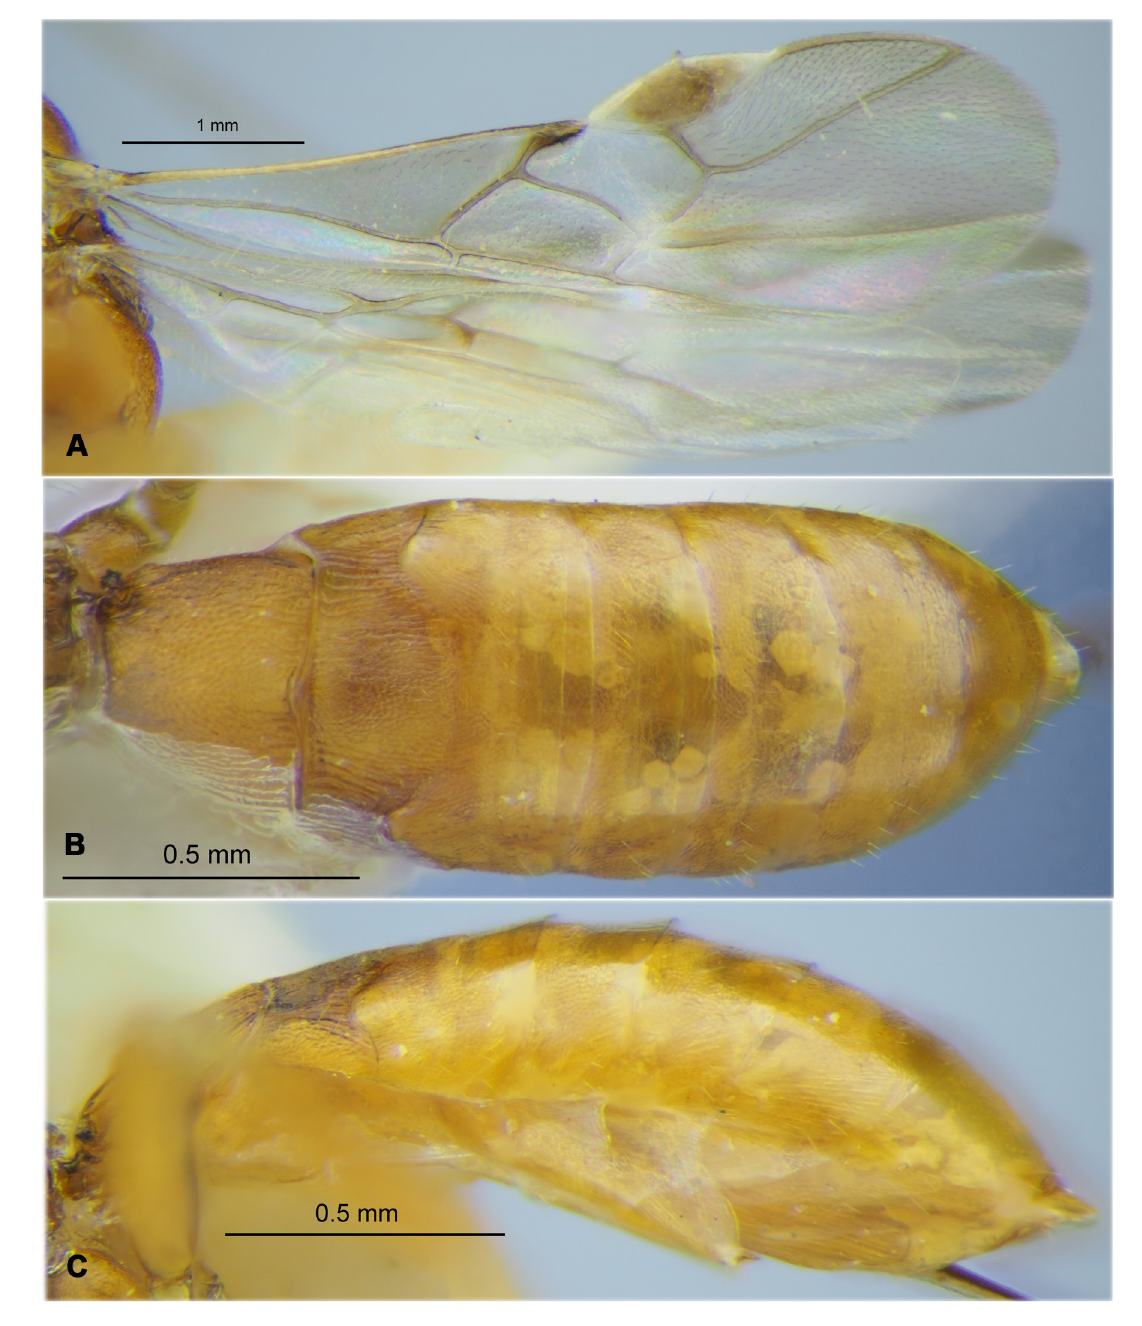
Fig. 33. Hecabalodes xylophagi Fischer, 1962, ♀ (RMNH). A . Wings. B . Metasoma, dorsal view. C . Metasoma, lateral